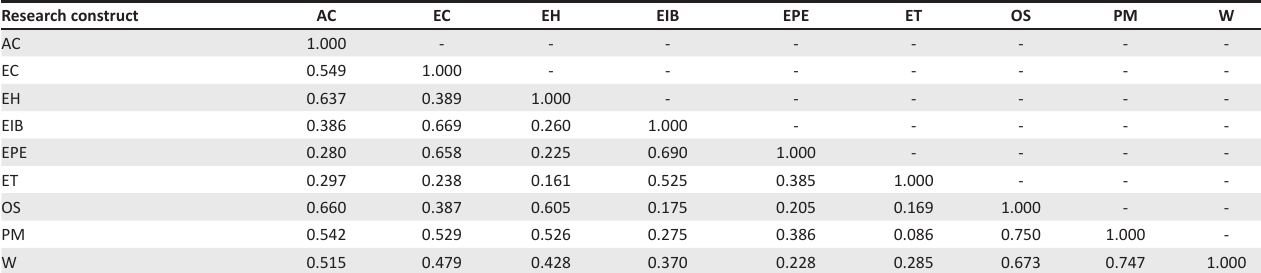
TABLE 2: Correlation between research constructs. Research construct